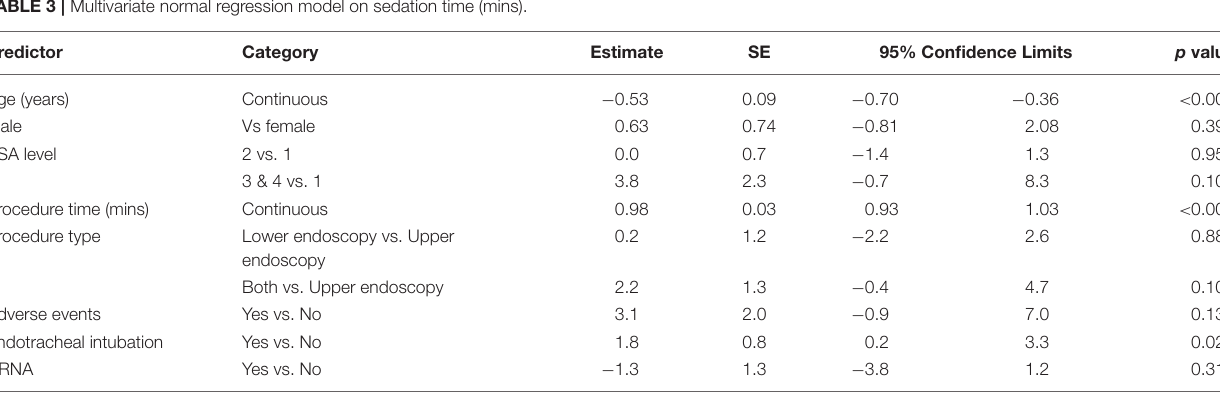
FIGURE 3 | Scatter plot for sedation time vs. procedure time with prediction line and 95% prediction limits ( N = 258, R-square = 92%). TABLE 3 | Multivariate normal regression model on sedation time